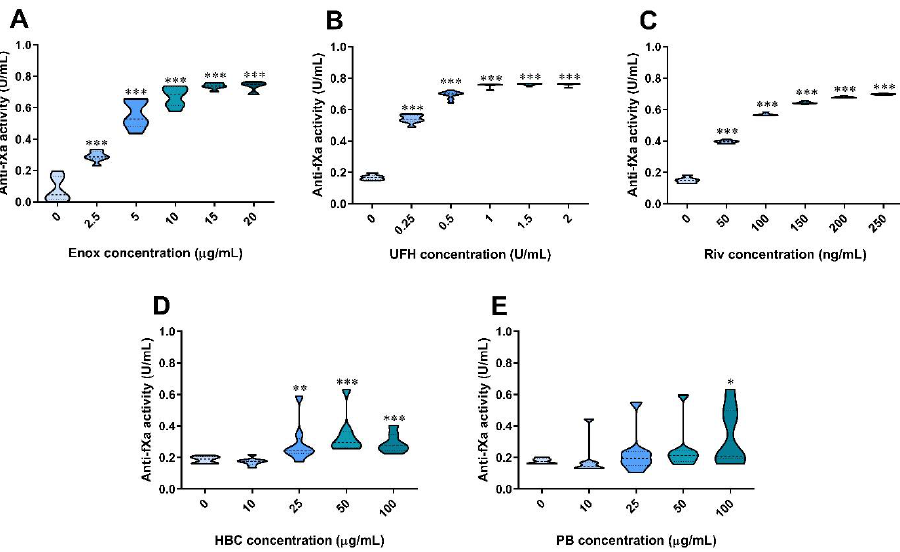
Figure 4. Effect of enoxaparin ( A ), UFH ( B ), rivaroxaban ( C ), HBC ( D ), and polybrene ( E ) on anti-factor Xa (anti-fXa) assay in human plasma. * p < 0.05, ** p < 0.01, *** p < 0.001 vs. control, Mann–Whitney test. The results are shown as violin plots with minimum and maximum values and analyzed with GraphPad Prism 8 software. Enox, enoxaparin; HBC, heparin-binding copolymer; PB, polybrene; Riv, rivaroxaban; UFH; unfractionated heparin.